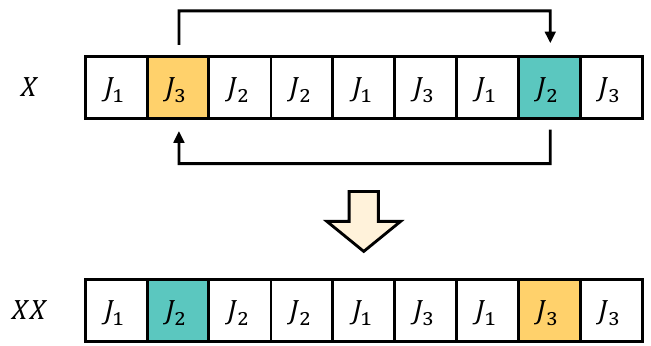
Figure 3. Exchanging process in VNS method [31].